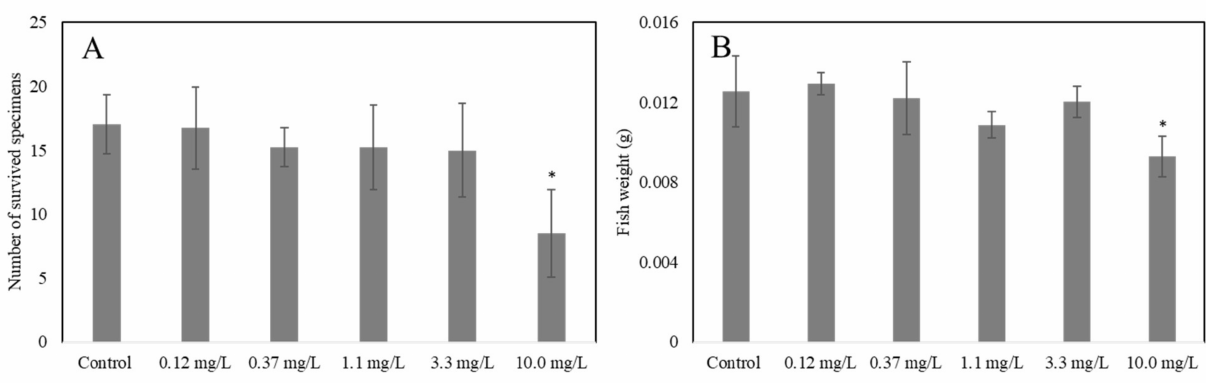
Figure 5. Significant effects indicated by asterisks (** p < 0.01), control versus treated, induced by ELT-dg suspension in D. magna (number of living offspring).